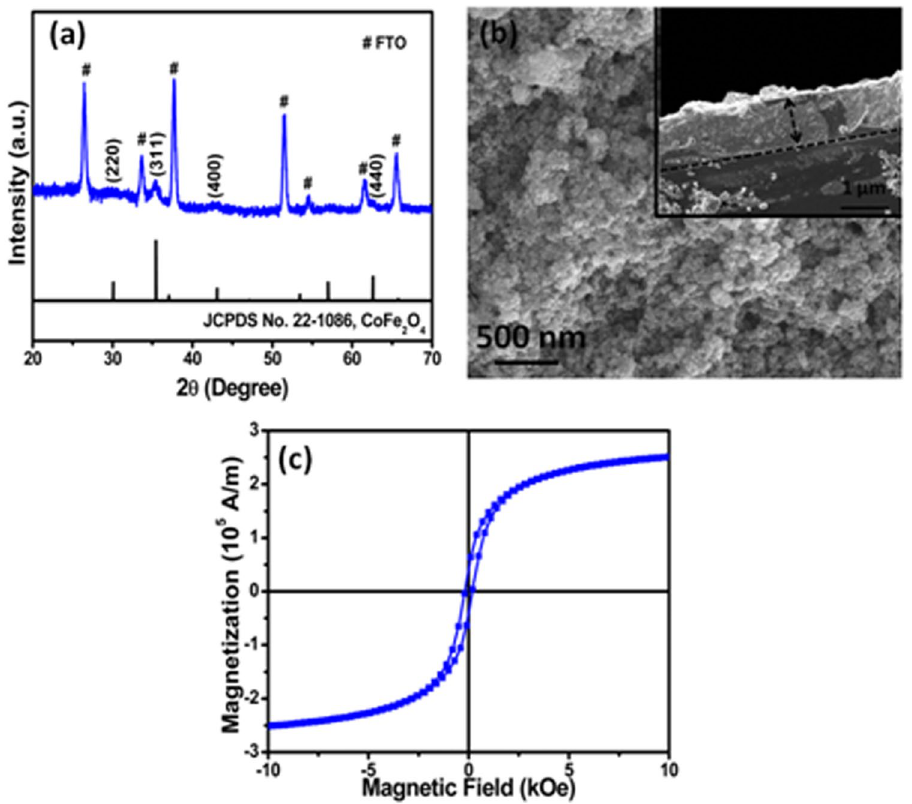
Figure 1. ( a ) X-ray diffraction pattern of CoFe 2 O 4 nanostructure film, ( b ) top view SEM image of CoFe 2 O 4 nanostructure film with the inset showing cross-sectional view of the SEM image ( c ) magnetization vs. field characteristic of CoFe 2 O 4 nanostructure